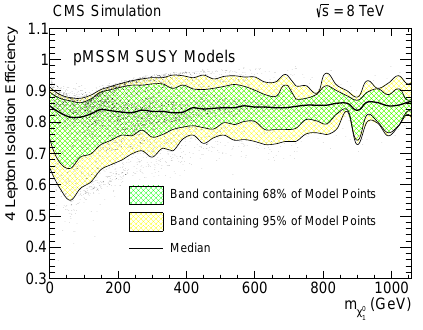
F igure 9. Isolation e ffi ciency for 4 leptons for the set of pMSSM models described in the text, as a function of the neutralino mass in the model. The green and yellow bands include 68% and 95% of the model points in the e ffi ciency distribution